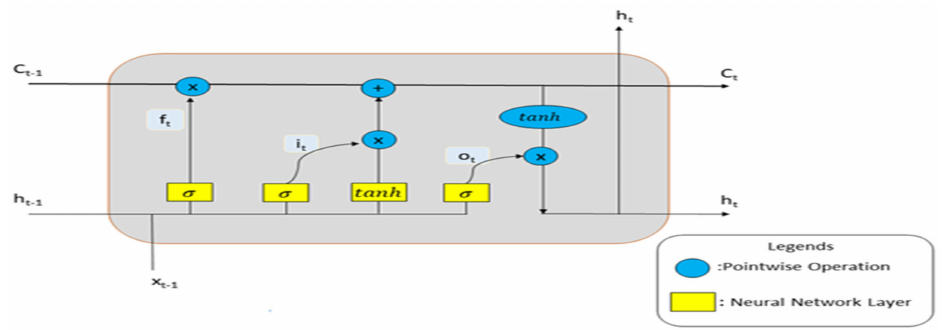
Figure 1. Representation of an LSTM